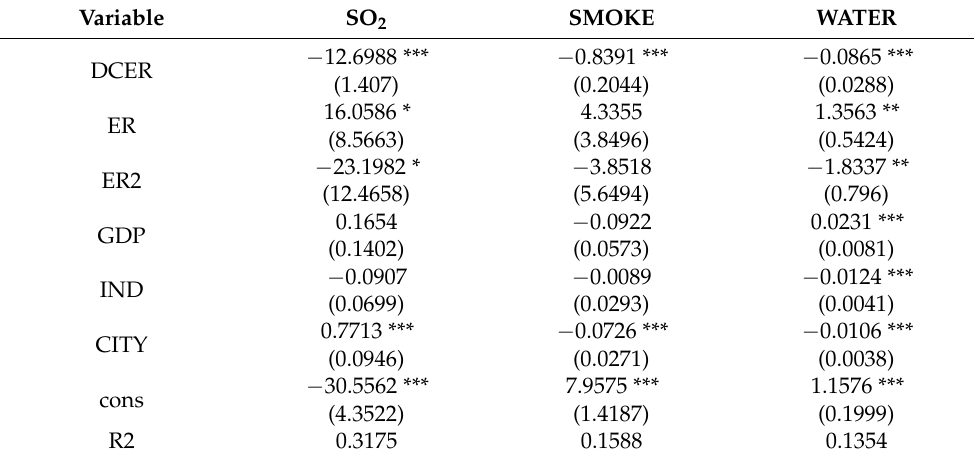
Table 5. Regression results of environmental regulation and CER on environmental